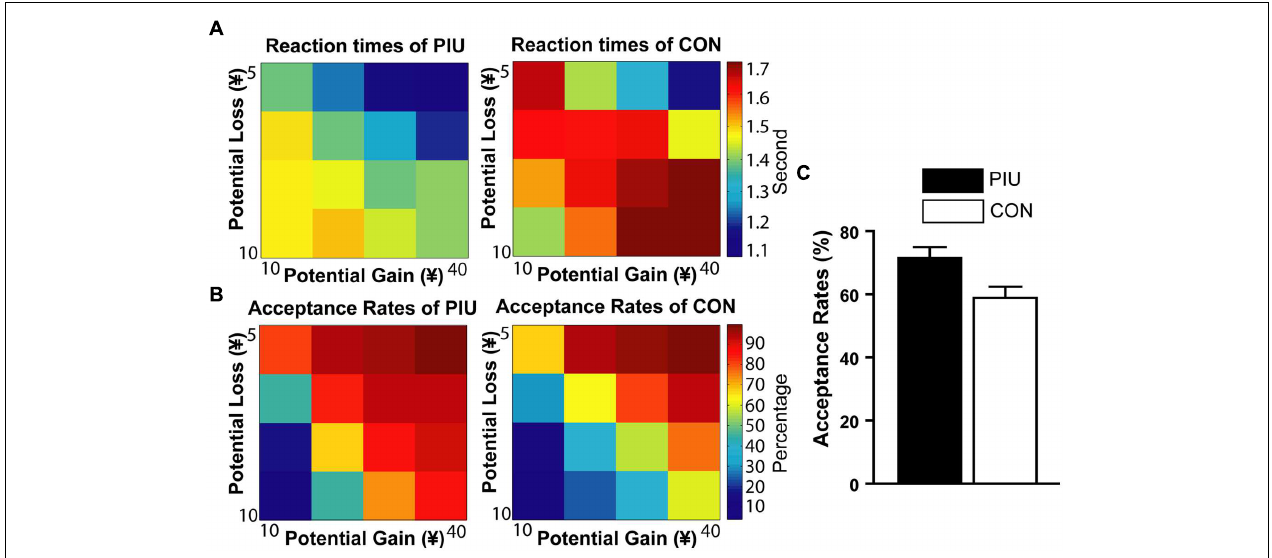
FIGURE 3 | Mixed gambles task performance at each level of gain/loss. (A) Color-coded heatmap of RTs for the PIU and control groups (red indicates slower RTs and blue indicates faster response times). (B) Color-coded heatmap of the percentage of gamble acceptance for the PIU and the control groups (red indicates a strong willingness to accept the gamble, and blue indicates a low willingness to accept the gamble). (C) PIU individuals had significantly higher acceptance rates of risky gables ( P ) than the control group.